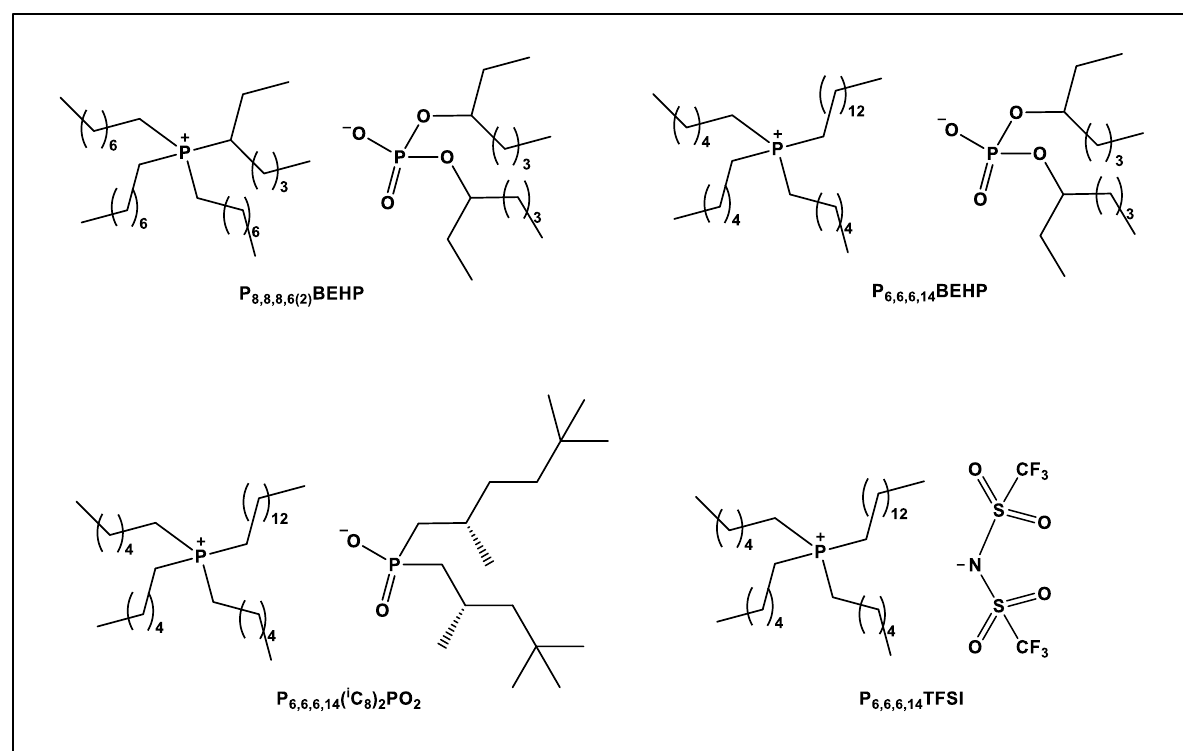
Figure 17. Chemical structure of quaternary phosphonium-based ILs used as titanium lubricant. Table 6. Friction coefficients of some ILs used as lubricants.